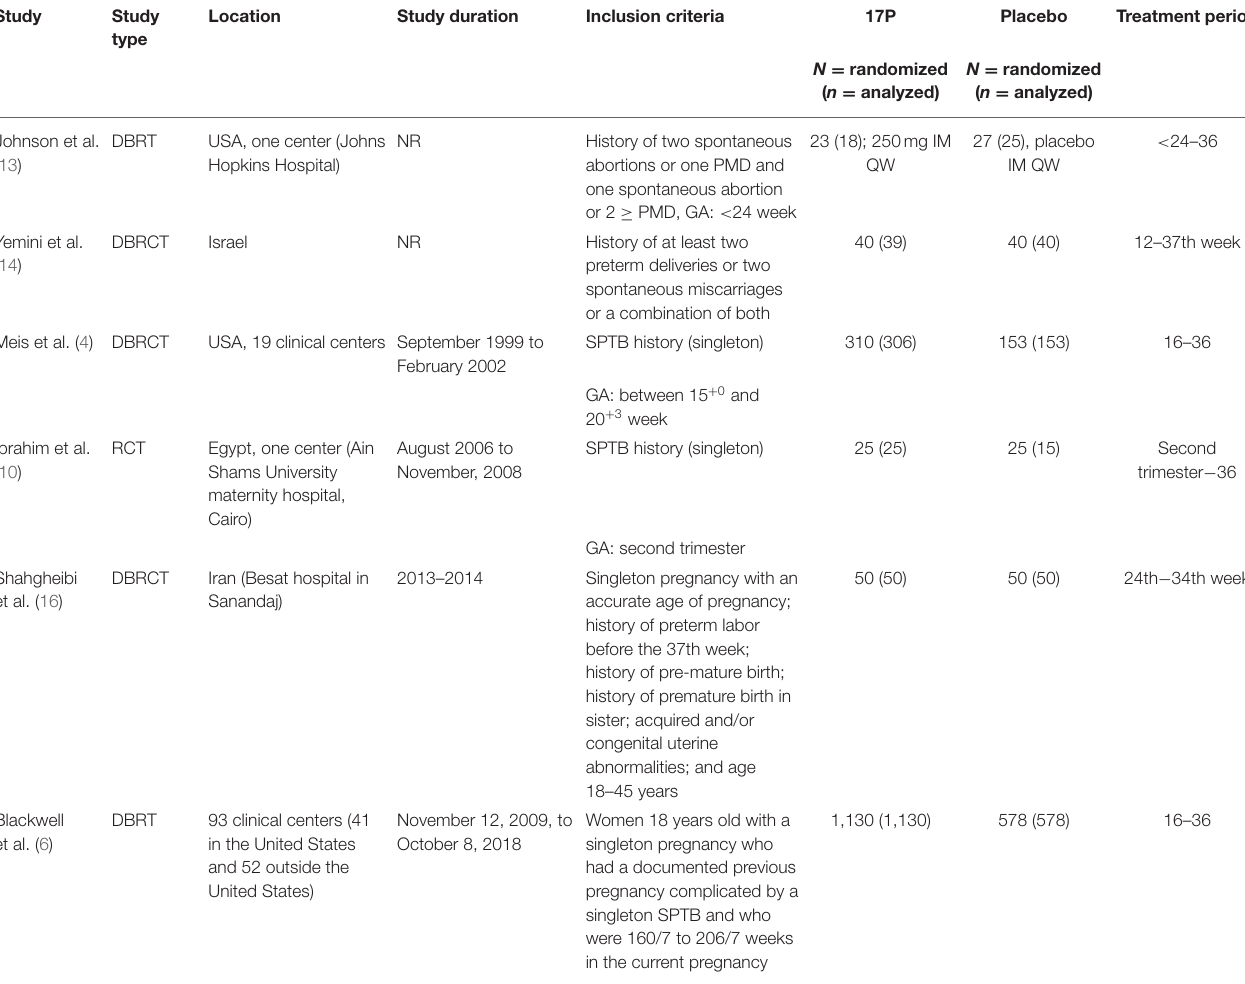
TABLE 1 | Characteristics of the works included in the systematic review and